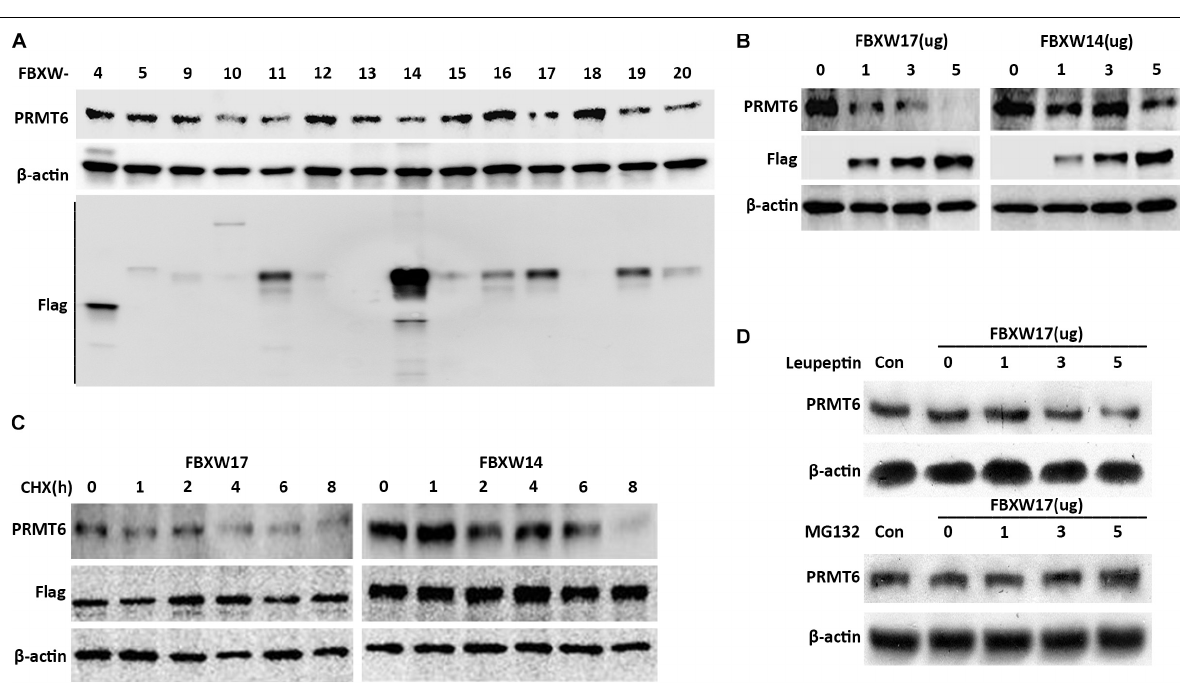
FIGURE 3 | FBXW17 targets the proteasomal degradation of protein arginine N-methyltransferase 6 (PRMT6). (A) Each pcDNA3.1-Flag/FBXW plasmid as indicated were separately delivered into MLE12 cells using an electroporation program. After 48 h of transfection, the cell samples were collected and lysed; the lysates were then analyzed using PRMT6, FLAG, and β -actin immunoblotting. (B) Different masses of pcDNA3.1-Flag/FBXW14 or FBXW17 plasmids were electroporated into MLE12 cells. Cell lysates were collected and subjected to PRMT6, Flag, and β -actin immunoblotting. (C) Three micrograms of FBXW14- or FBXW17-overexpressed plasmids were electroporated delivered into MLE12 cells. After 48 h of transfection, the cells were treated with 100 µ g/ml cycloheximide (CHX) for five time points as indicated. The immunoblotting of PRMT6, FLAG, and β -actin was tested. (D) The MLE12 cells were electroporated transfected with 0, 1, 3, and 5 µ g of FBXW17 plasmids for 48 h. Before collection, cells were, respectively, treated with 20 µ M of MG132 or 100 µ M of leupeptin. Cells were harvested and lysed. Lysate was analyzed by conducting immunoblotting with the indicated antibodies. Data represent n = 3 separate